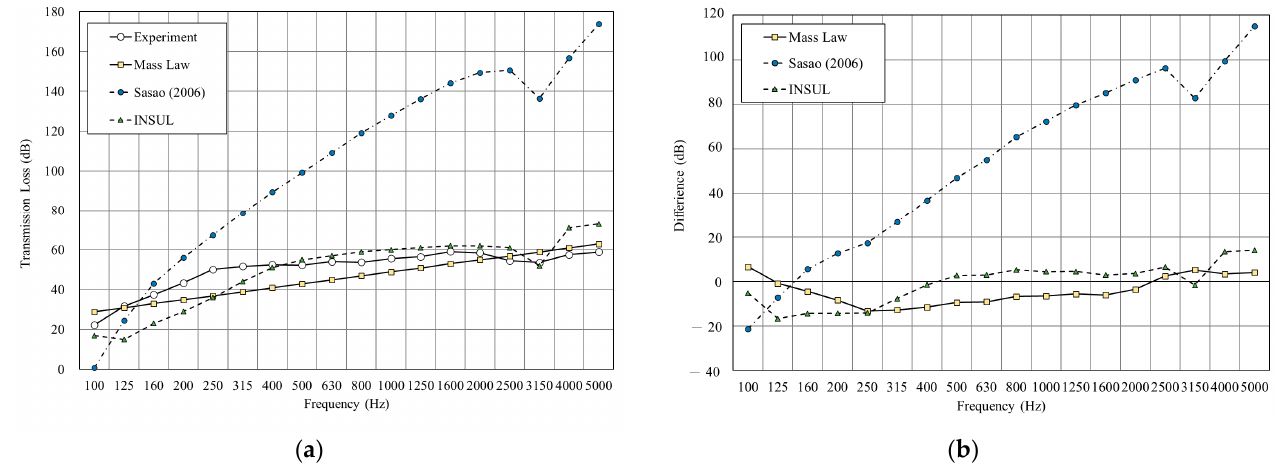
Figure 19. Comparison between experimental and predicted results of CLT + GB with 50 mm cavity (C3). ( a ) The sound insulation performance of experiment and prediction. ( b ) The RMSE results of different prediction models.